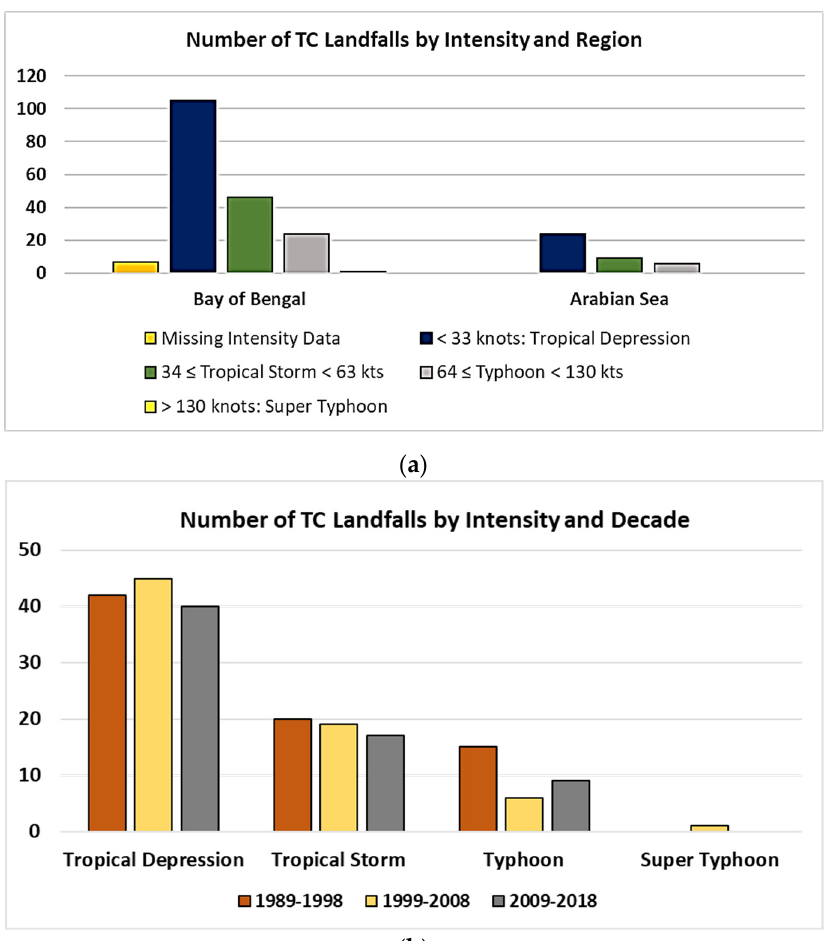
Figure 8. Histogram of: ( a ) the number of TC landfalls in the Bay of Bengal and Arabian Sea by JTWC intensity scale; and ( b ) the number of TC landfalls in each 10-year period separated by JTWC intensity category.